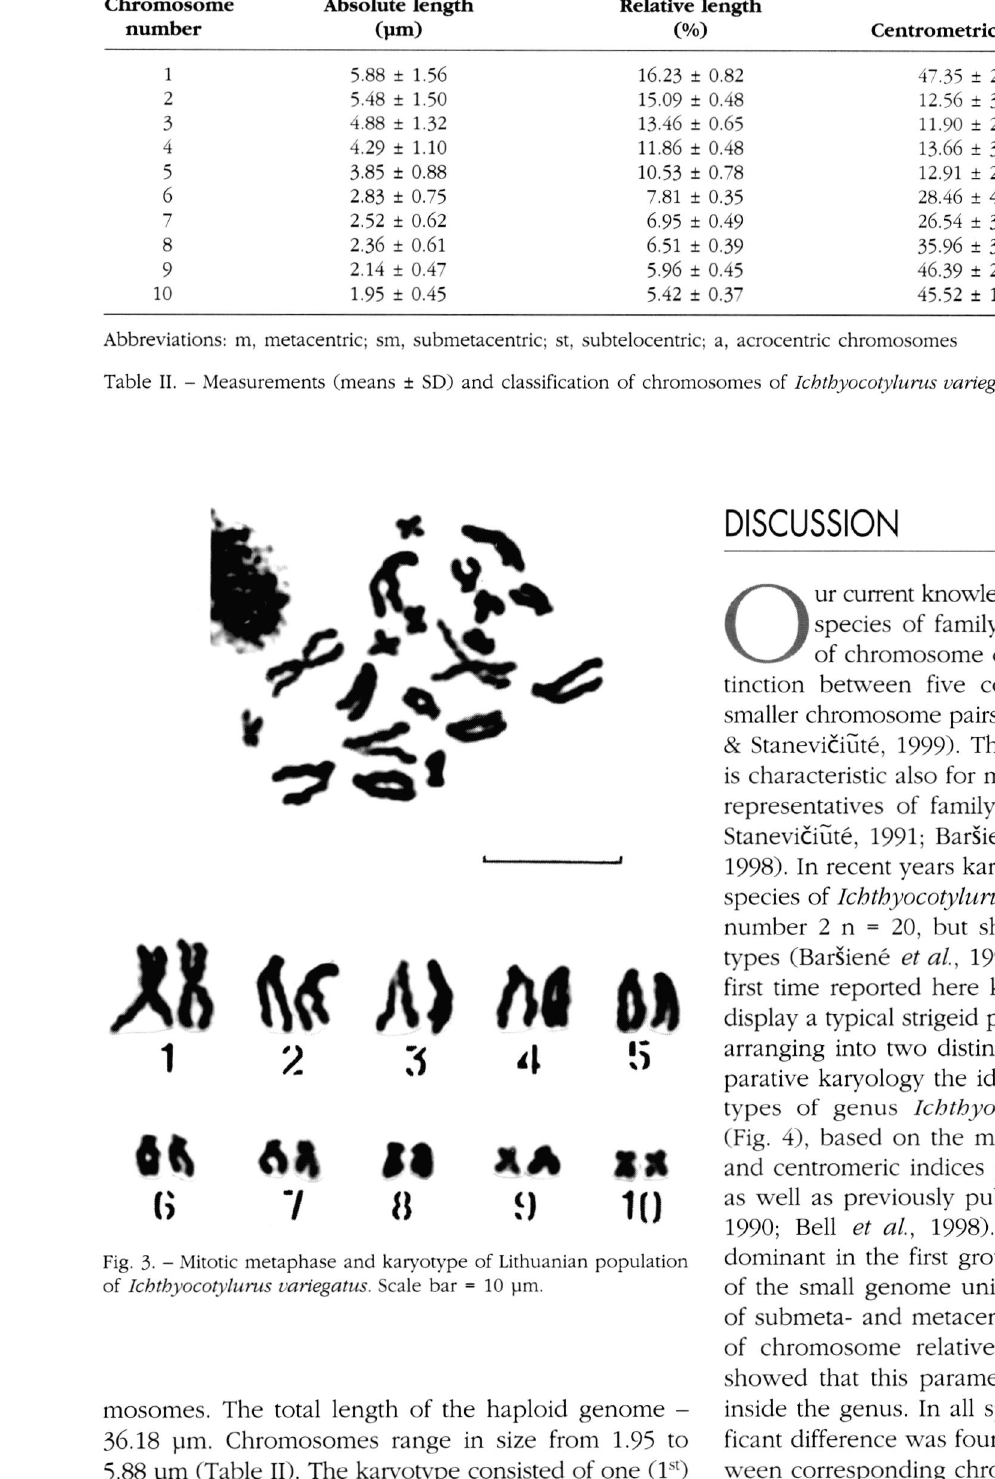
mosomes. The total length of the haploid genome - 36.18 pm. Chromosomes range in size from 1.95 to 5.88 pm (Table II). The karyotype consisted of one (1 st ) pair of large and two small (9 th and 10 th ) pairs of meta­ centric chromosomes; one pair (6 th ) of submetacentric and ( 8 t h ) submeta-metacentric chromosomes; four mono-armed (pairs 2-5 represent subtelo-acrocentic units). Chromosomes of 7 th pair represented by sub- meta-subtelocentic